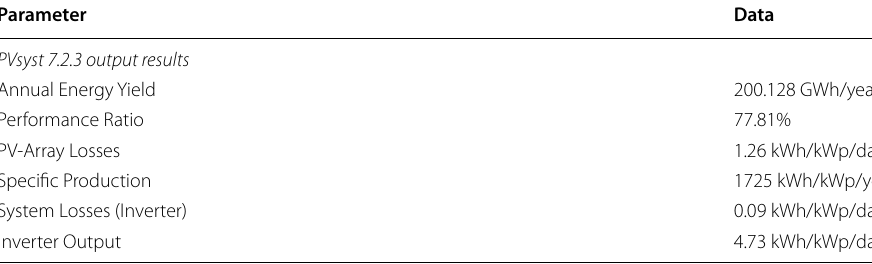
Table 6 Main results 116 MWp LSS project modelling